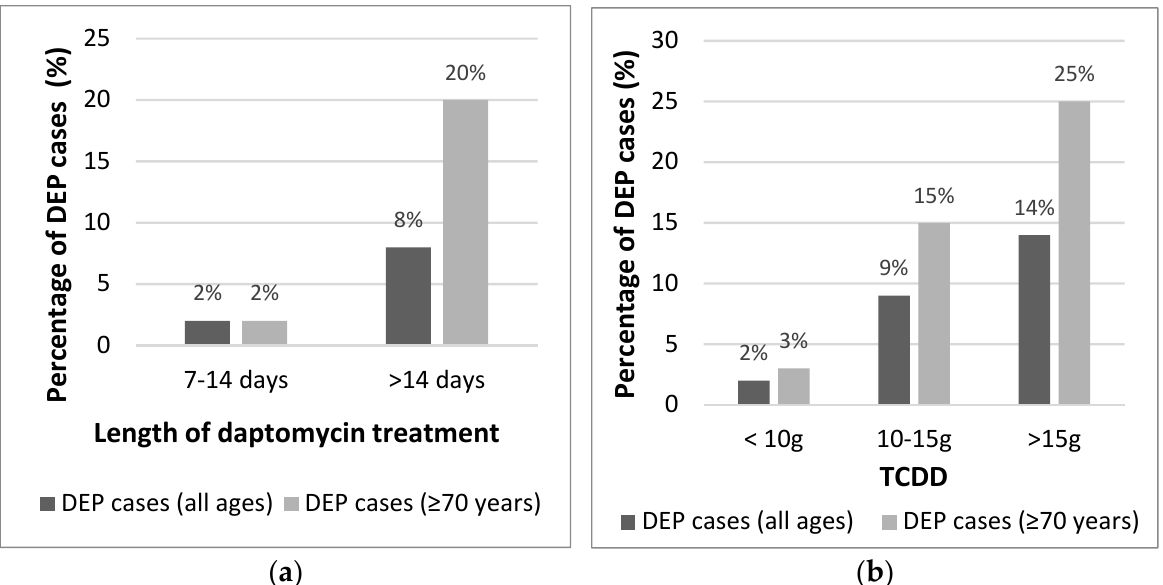
Figure 1. Percentage of Daptomycin-induced eosinophilic pneumonia (DEP) cases in the whole cohort and in those aged ≥ 70 years by ( a ) Length of therapy and by ( b ) The total cumulative dose of daptomycin (TCDD).